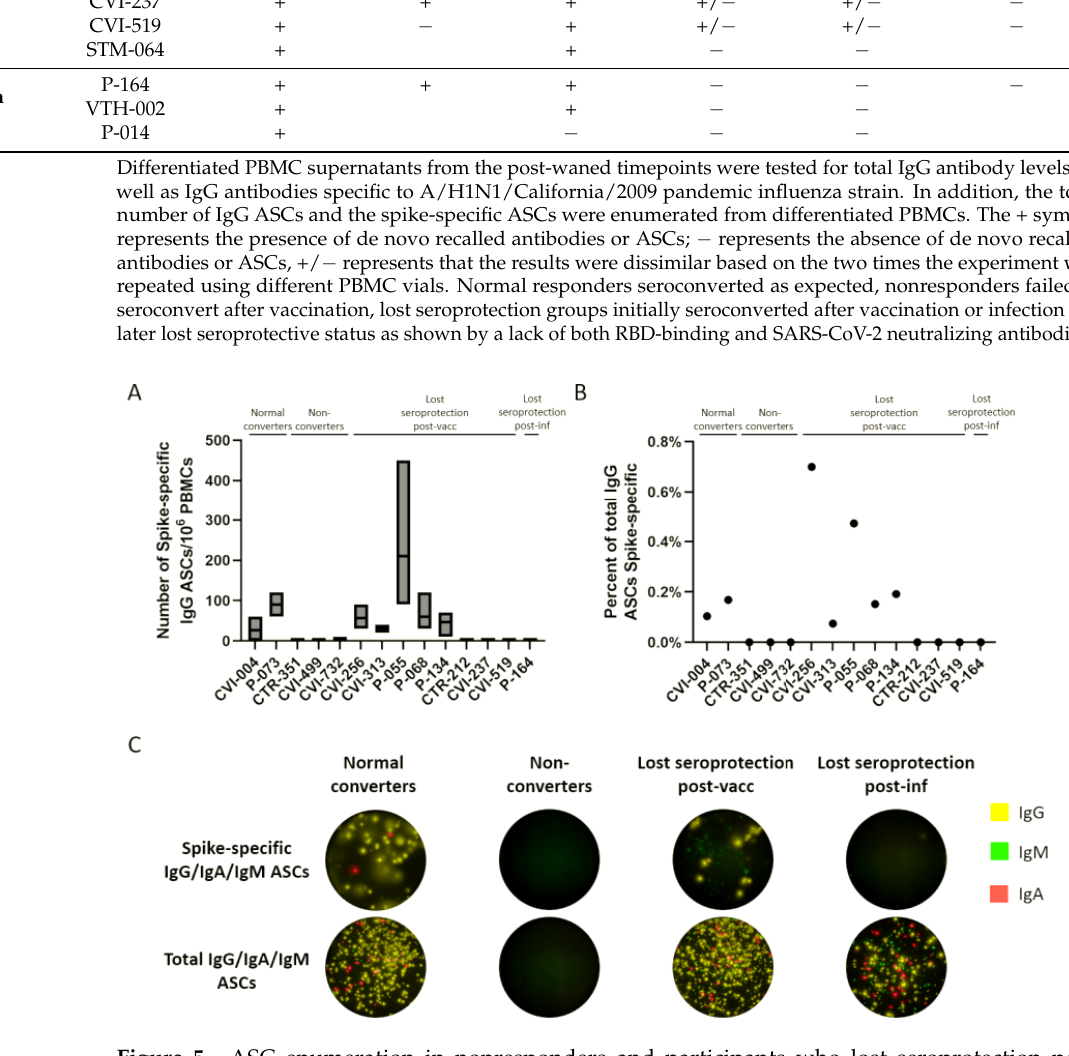
Figure 5. ASC enumeration in nonresponders and participants who lost seroprotection post-vaccination or infection. ( A ) Number of spike-specific IgG ASCs out of 10 6 in vitro differentiated PBMCs. ( B ) Percent of total IgG ASCs that are spike-specific. ( C ) Representative wells for normal converters, nonconverters, and participants who lost seroprotection post-vaccination or infection, for spike-specific and total ASCs.